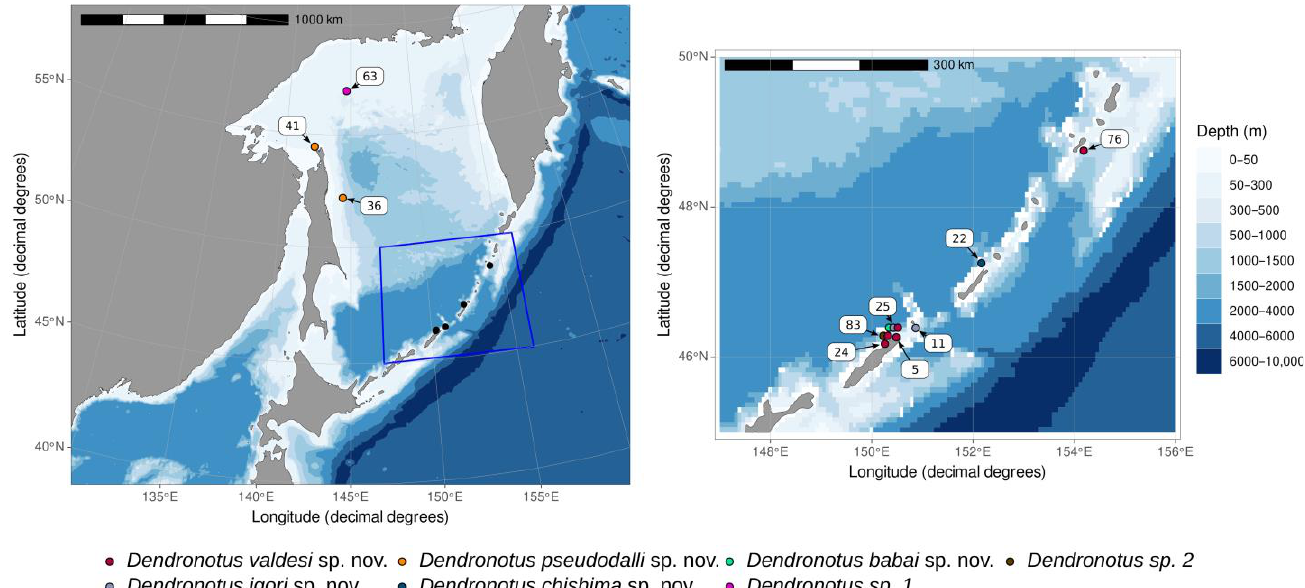
Figure 1. Map of the North-West Pacific (the Sea of Okhotsk region) showing collection sites (stations) and respective nudibranch species found.